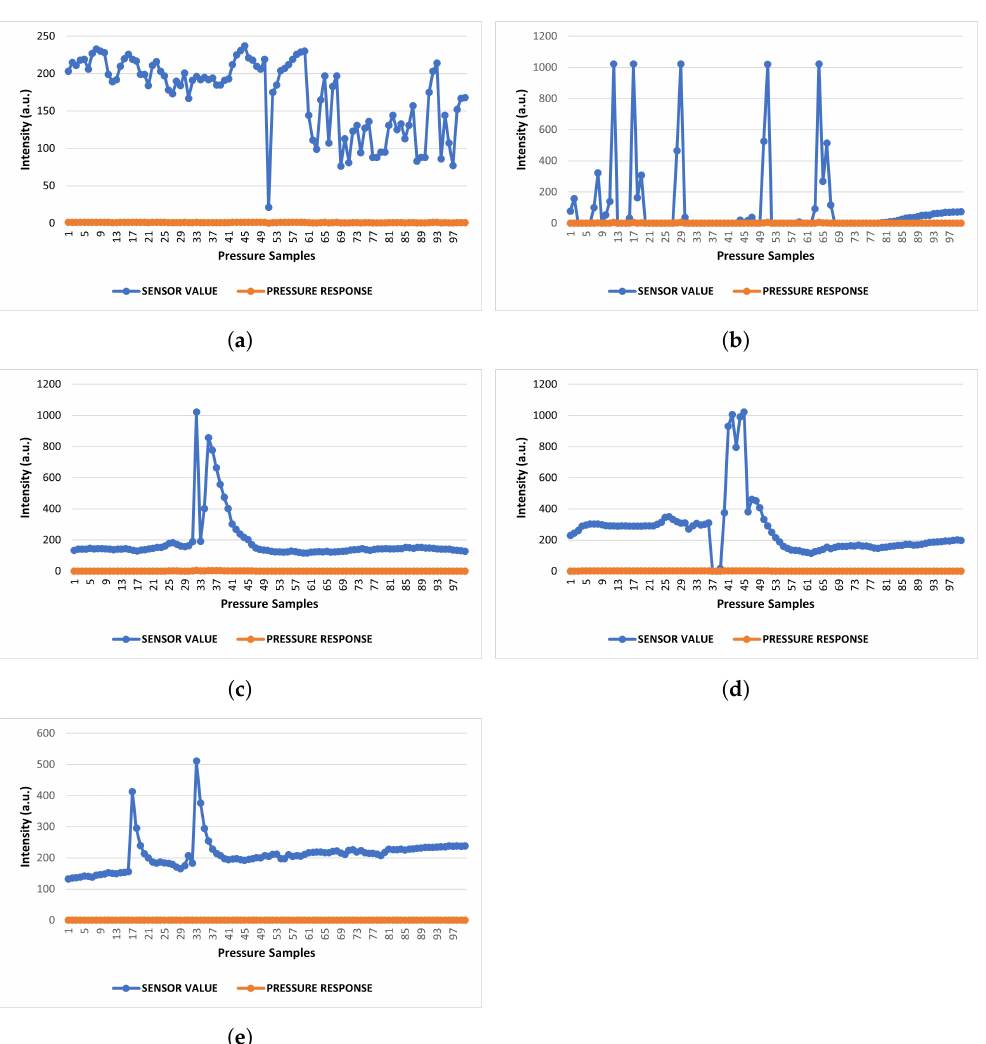
Figure 3. Pressure responses from different cases. ( a ) Ambient responses; ( b ) Partial removal pressure responses; ( c ) Complete removal pressure responses (quick); ( d ) Complete removal pressure responses (slow); ( e ) Drop deformation test